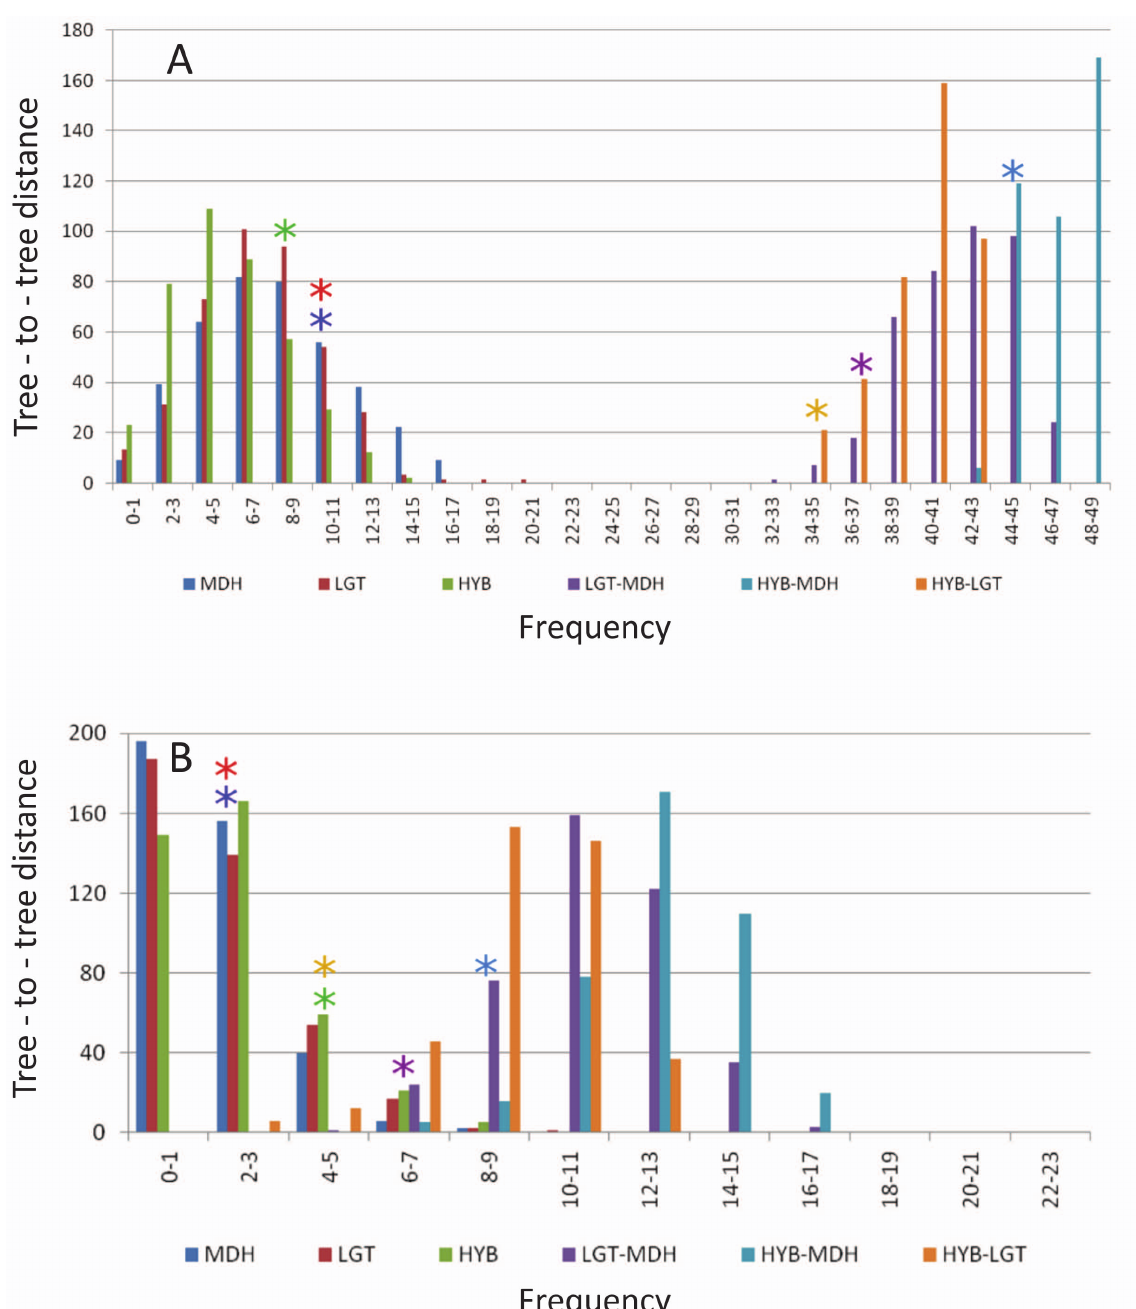
Figure 4. Null and observed genes tree-to-tree distance distributions. (A) Tree-to-tree distances between 20 trees drawn from the posterior distribution of each observed gene tree from one another (right hand side; 400 combinations per pair wise comparison) and the observed gene trees to 20 simulated gene trees that makes up the null distribution for each observed gene tree (left hand side). The position of the 80% critical value for each of the three null distributions is marked (blue: MDH, red: LGT and green: HYB asterisks; left hand side). The lower boundary of the 95% credibility interval of each observed pair of genes’ tree-to-tree distances are marked (purple: LGT-HYB, light blur: HYB-MDH and orange: HYB-LGT asterisks; right hand side). The test statistic, w , is the distance between the closest left and right hand asterisks and does not overlap, thereby indicating a rejection of the null hypothesis of lineage sorting alone. (B) Tree-to-tree distances as in A, but after the removal of individuals with a putative hybrid origin. Asterisks also as in A. In this case, removal of individuals of putative hybrid origin results in a zero result for w , thereby indicating that the null hypothesis of lineage sorting alone cannot be rejected. The interpretation is that those individuals that have been removed (compared to A) require an alternative explanation beyond lineage sorting in order to account for their incongruent placement among the three gene trees, whereas those that remain in B do not.